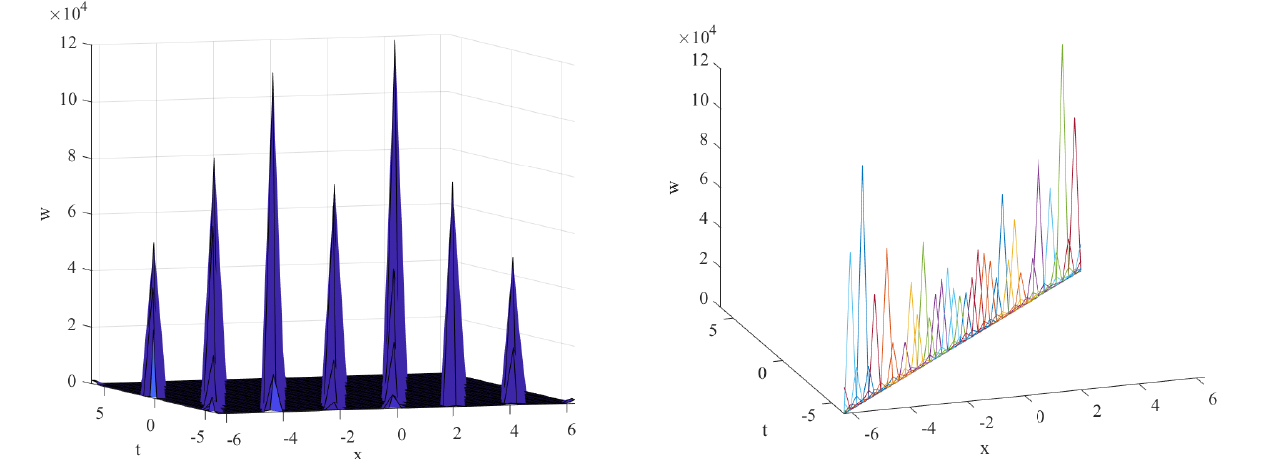
Figure 4. A 3D plot for a periodic solution of W 59 ( ξ ) under the values a 1 = a 3 = 0, a 2 = 1.1, a 4 = 1 = α = β inside the domain − 2 π ≤ x , t ≤ 2 π .